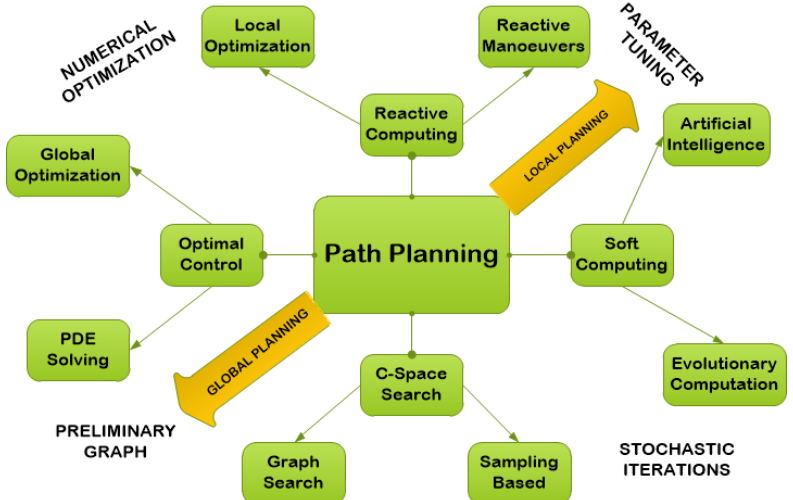
Figure 1. Schematic showing different path planning methods.